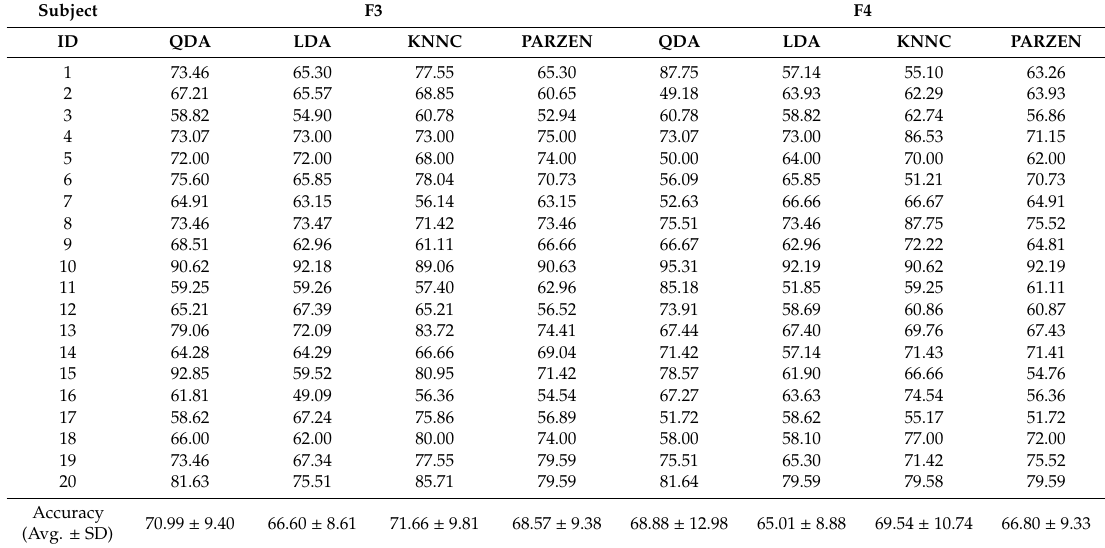
Table 2. Result of leave-one-out cross validation using the EEG frequency spectrum (1–50 Hz) as input in the machine learning approaches including quadratic discriminant analysis (QDA), linear discriminant analysis (LDA) (parametric), K-nearest neighbor classifier (KNNC) and Parzen density-based (PARZEN) (nonparametric). The performance of the classification system is compared in accuracy (%) during inter-subject and intra-subject variability at frontal lobe (F3 and F4) of the brain.